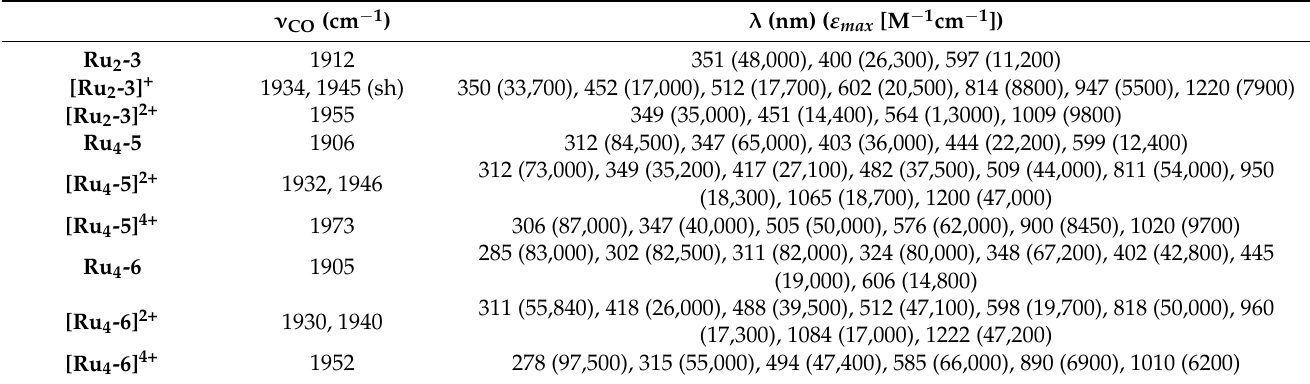
Table 2. IR–NIR and UV–vis–NIR spectroscopic data of the compounds Ru 2 -3 , Ru 4 -5 , and Ru 4 -6 in their neutral, dicationic, and tetracationic states [a]